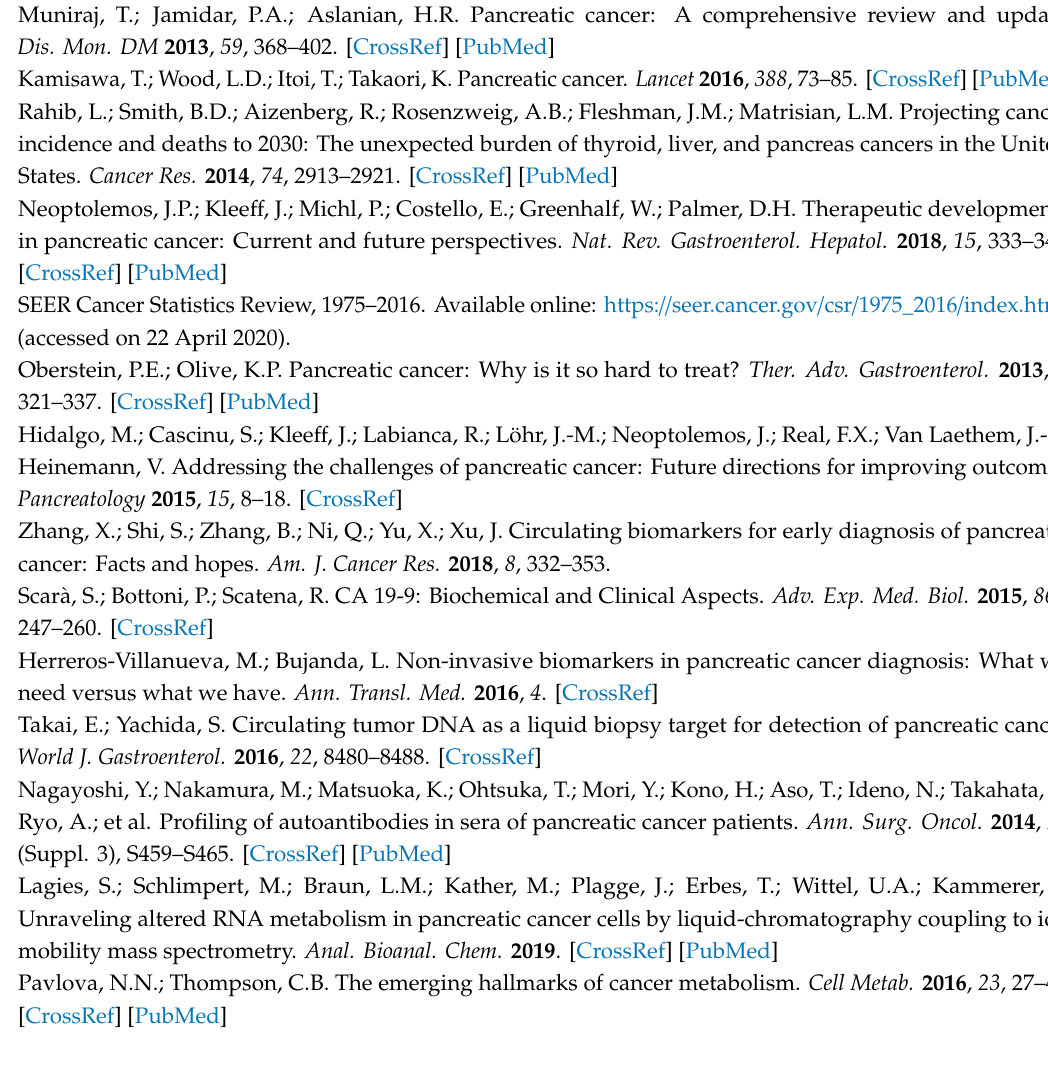
Supplementary Figure S1: Metabolomics analysis of gemcitabine treated MiaPaCa2 and Panc-1 cells. Supplementary Figure S2: Principal component analysis of parental and resistant MiaPaCa-2 and Panc 1 cells. Supplementary Figure S3: Fold change of aspartic acid and N-carbamoyl-aspartic acid. Supplementary data file SD1: GC / MS results of nab-paclitaxel treatment in PDAC cell lines. Supplementary data file SD2: GC / MS results of nab-paclitaxel resistance in PDAC cell